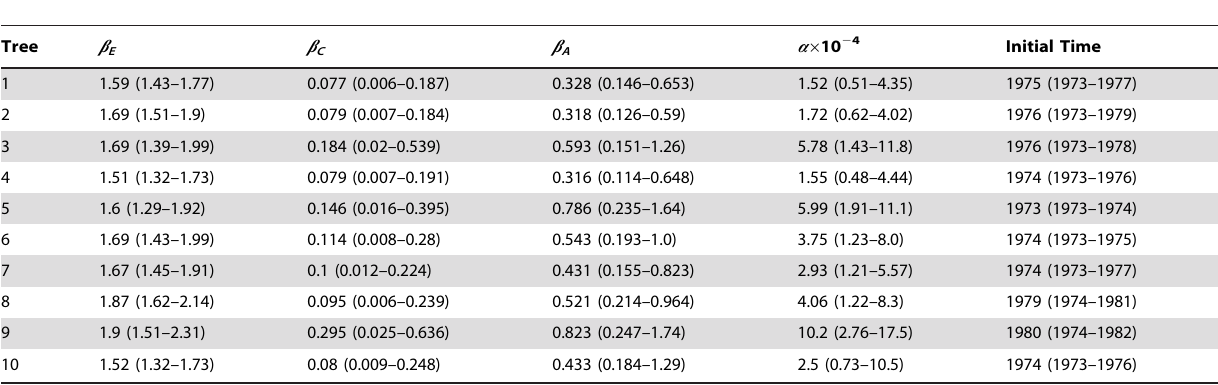
Table 2. HIV parameter